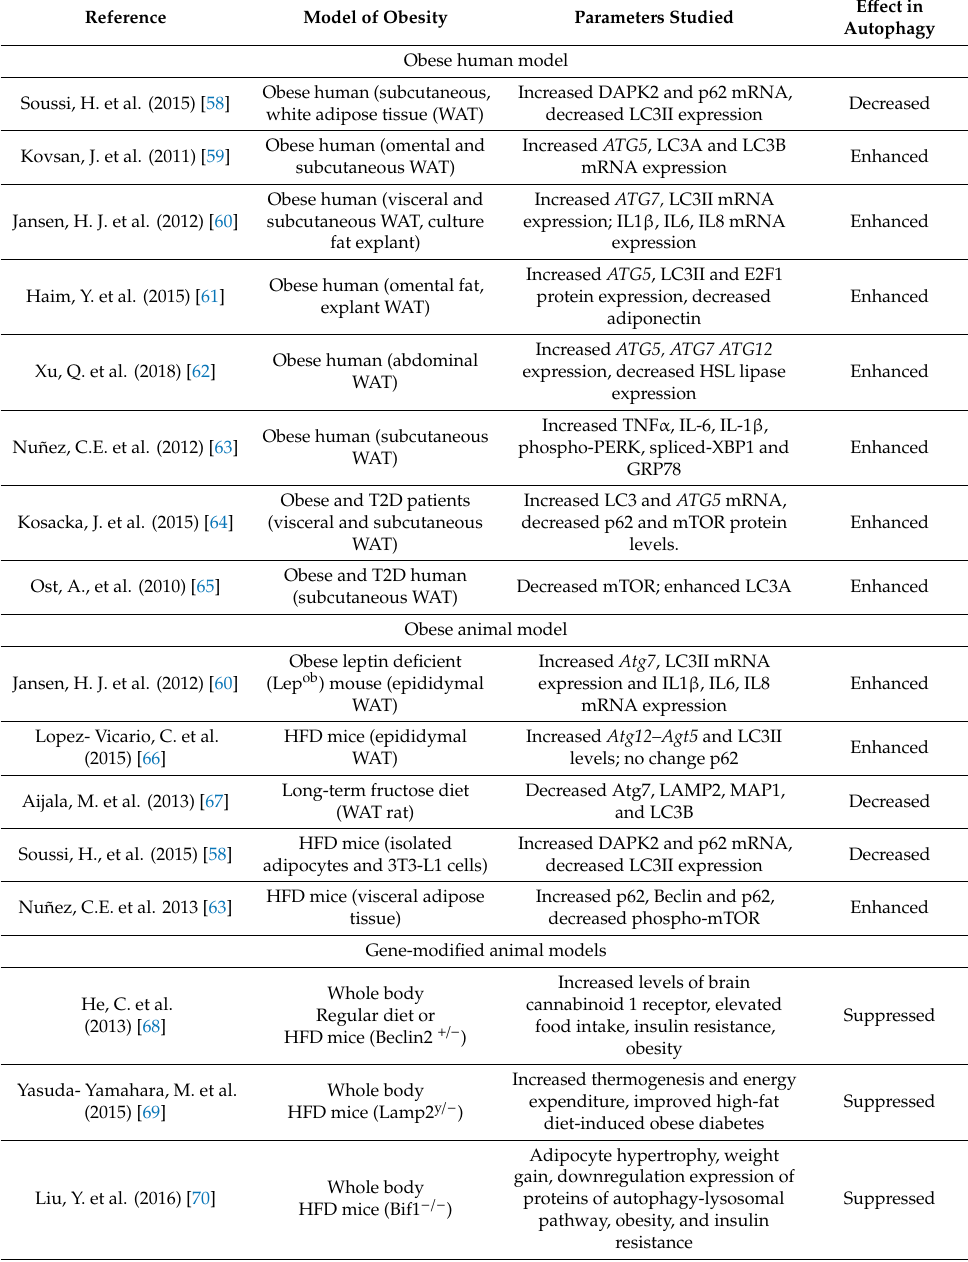
Table 1. E ff ects on autophagy in adipose tissue of obese models (human and rodents) and gene-modified animal